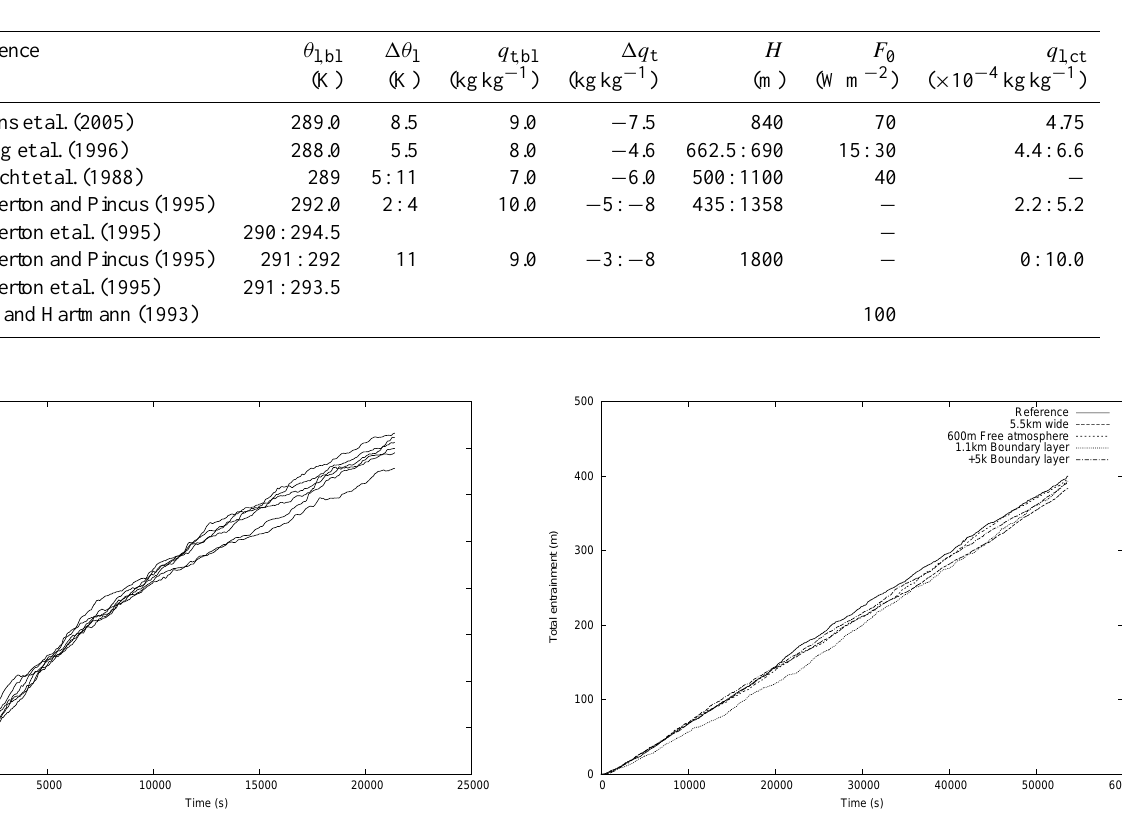
Table 1. The ranges of large-scale boundary layer values found in various published sources.